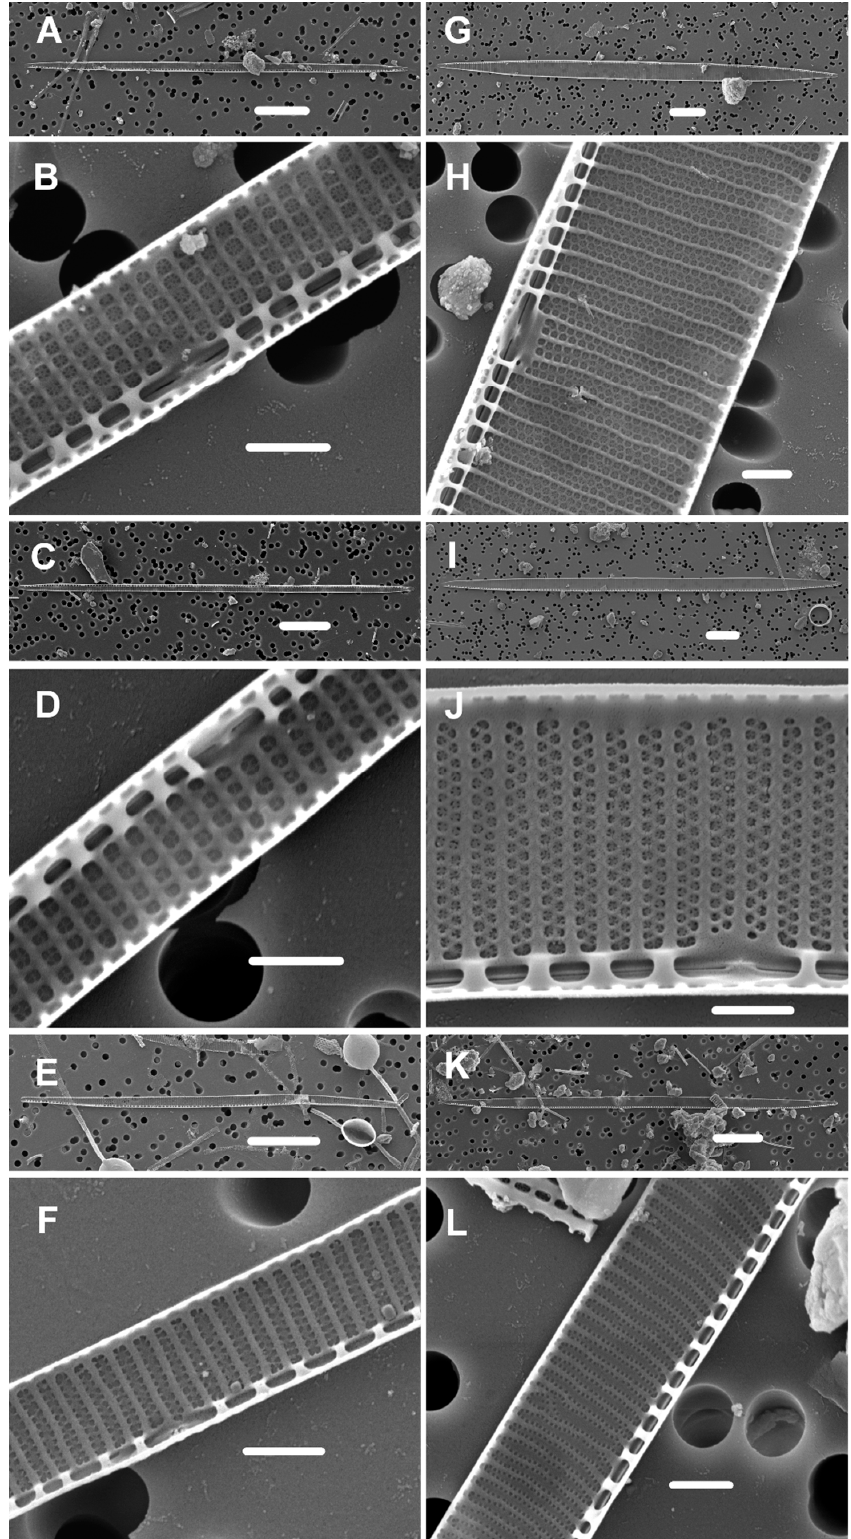
Figure 6. The Pseudo-nitzschia species observed by SEM: ( A , B ) P. calliantha ; ( C , D ) P. pseudodelicatissima/cuspidata ; ( E , F ) P. delicatissima/arenysensis ; ( G , H ) P. fraudulenta ; ( I , J ) P. subfraudulenta ; ( K , L ) P. multistriata . Scale bars represent 10 µm in ( A , C , E , G , I , K ) and 1 µm at ( B , D , F , H , J , L ).